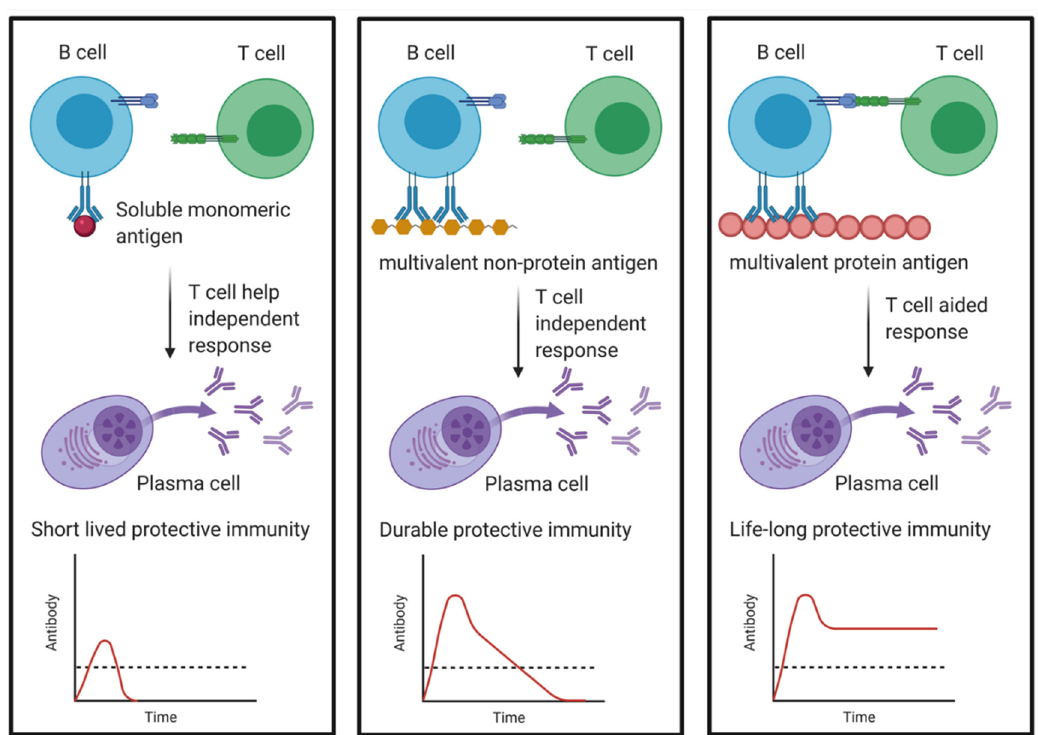
Figure 4. The impact of the nature of the antigen on the longevity of the induced plasma cell and corresponding antibody levels. Soluble monomeric antigens are not as efficient at activating B-cell differentiation and if they also receive little T-cell help, only short-lived plasma cells are induced. Multivalent non-protein antigens also lack T-cell help, but due to BCR crosslinking, more intrinsic survival potential is generated in the activated plasma cells. Multivalent protein antigen will lead to BCR crosslinking and a T-cell mediated response giving rise to plasma cells able to persist for decades or even a whole life in the BM niches. Without T-cell help, the plasma cells are typically not able to switch isotype and only produce IgM, while plasma cells supported by T-cells switch to classes such as IgG, IgE or IgA. The dashed line depicts the protective threshold of serum Ig. (Created with BioRender.com).